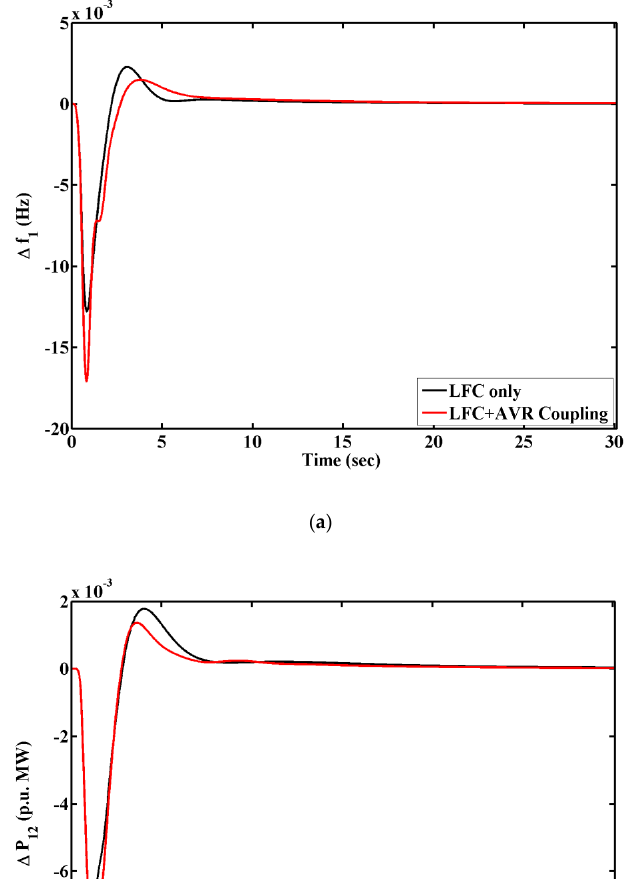
∆ Ptie ∆ f 1 , ( b ). 12 and ( c ). 2